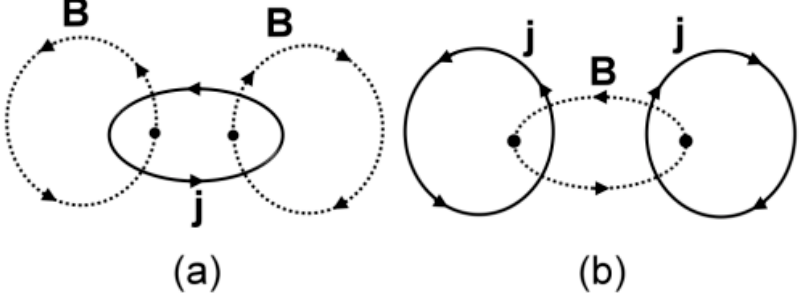
Figure 4. ( a ) Idealized topological configuration with poloidal B and toroidal j ’s. ( b ) The same with toroidal B and poloidal j ’s. See text. After Gregori (2002) [2].